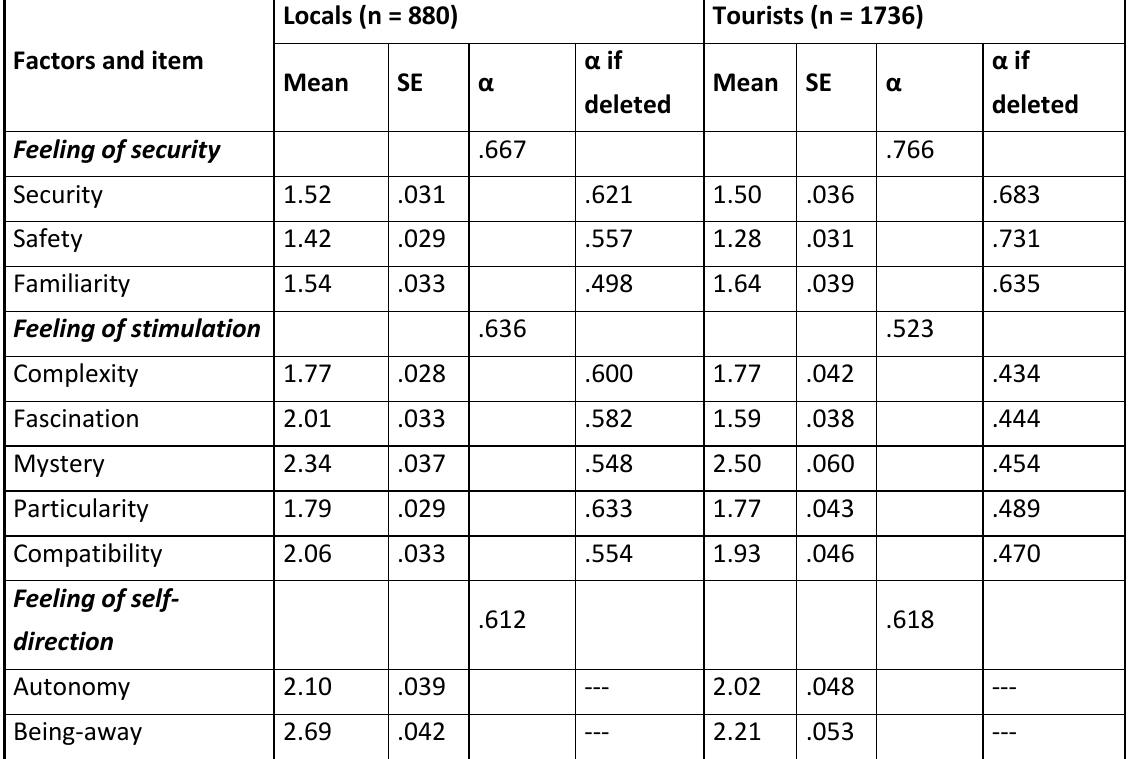
Table 3: Descriptive statistics for each item respectively for each related concept together with Cronbach’s alpha (α) for the factors are shown. SE is the abbreviation for standard error of m ean, n denotes the sample size – and α if deleted gives the value of Cronbach’s alpha if the item in the corresponding row is excluded from the computations.